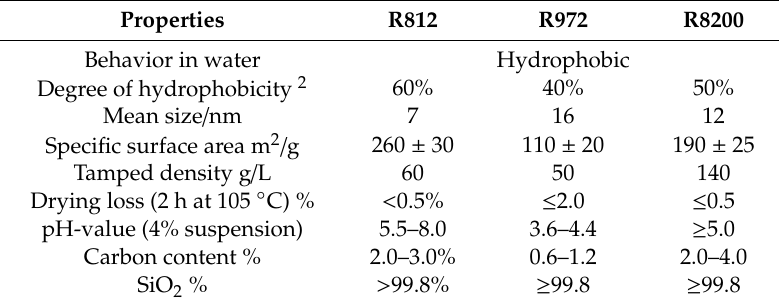
Table 2. Properties of fumed silica used in the study 1 .